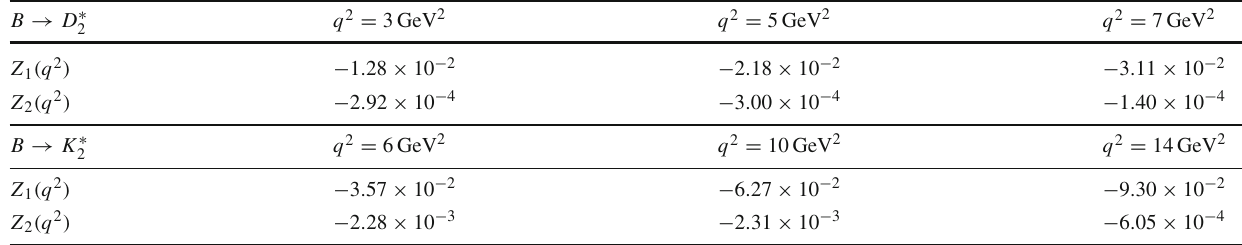
transition, and at q 2 = ( 6 , 10 , 14 ) GeV 2 for B → K ∗ 2